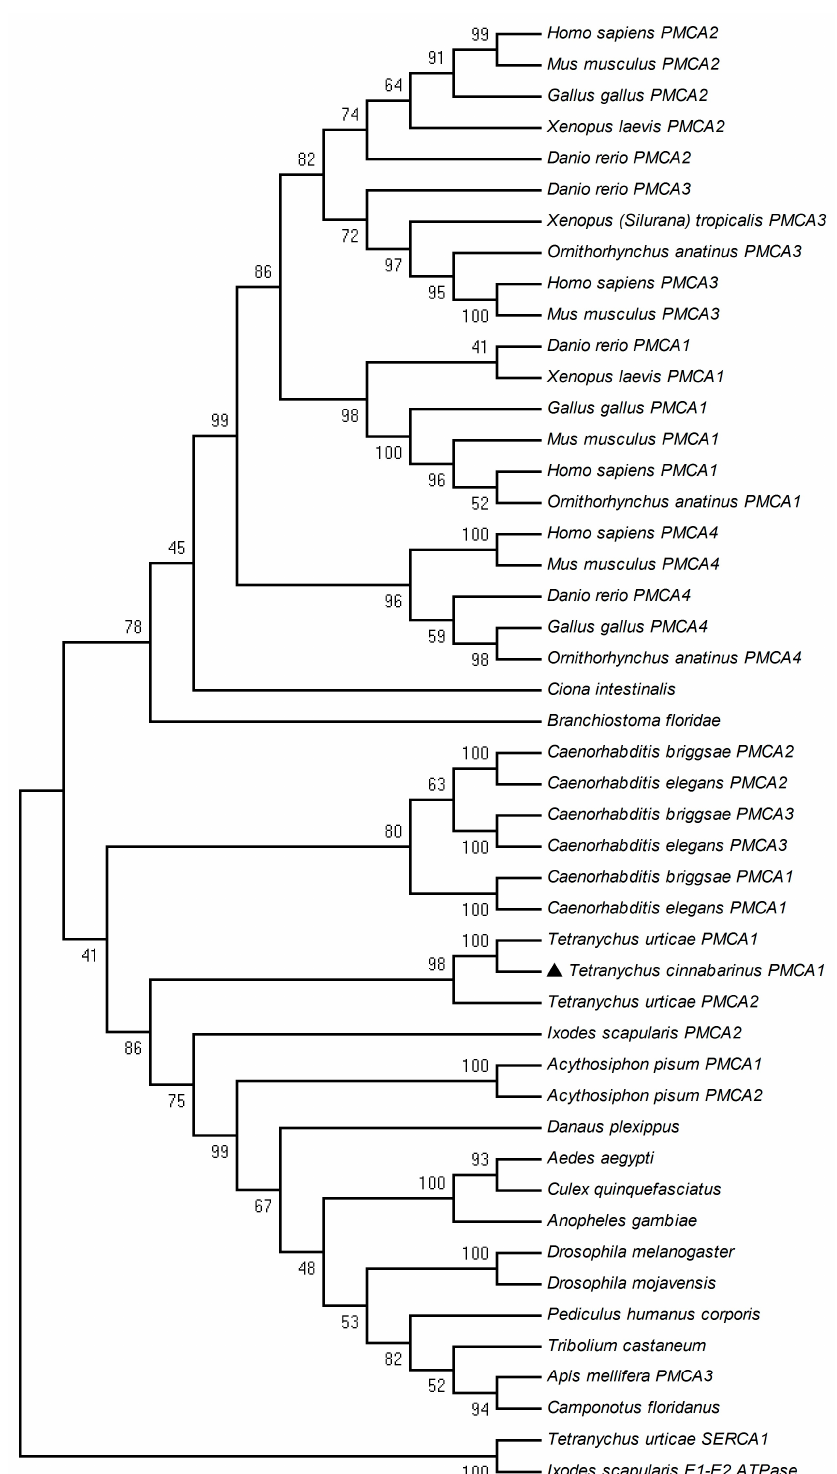
Figure 3. Phylogenetic analysis of TcPMCA1 obtained from the carmine spider mite ( Tetranychus cinnabarinus (Boisduval)). The phylogenetic tree was constructed using Molecular Evolutionary Genetics Analysis (MEGA) 5.04 using the neighbor-joining method based on amino acid sequences. TcPMCA1 was indicated by “ ▲ ”. Bootstrap support values derived from 1000 replicates are shown on the branches. Sequence accession numbers are given in Electronic Supplementary Material, Table S1.